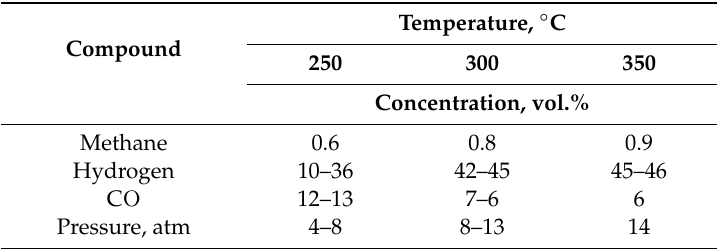
Table 7. Changes of the gas phase composition and pressure in the autoclave during the formic acid decomposition as a function of